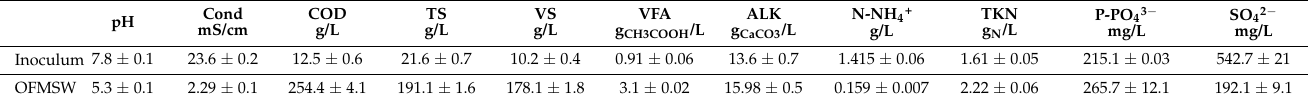
Table 1. Characteristics of OFMSW and